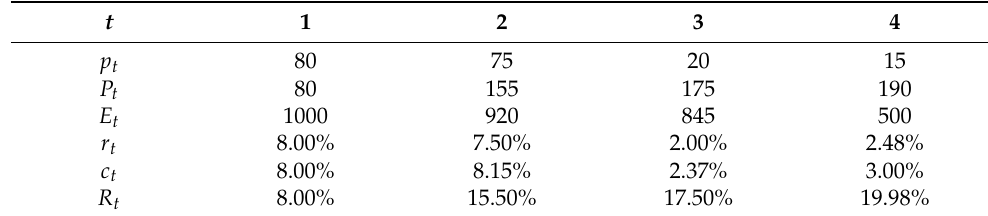
Table 5. Portfolio ( EAD = 1000 ) performance in 4 years ( T = 4